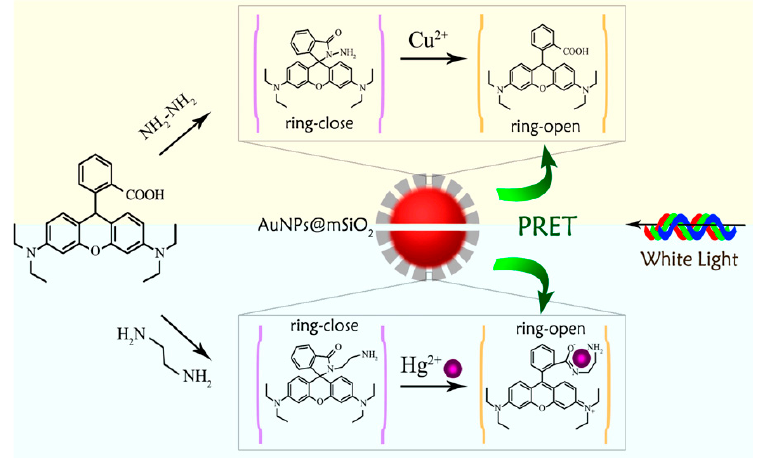
Figure 26. Illustration of the core–shell structure of AuNPs coated with mesoporous silica and the injection of rhodamine derivatives [103].